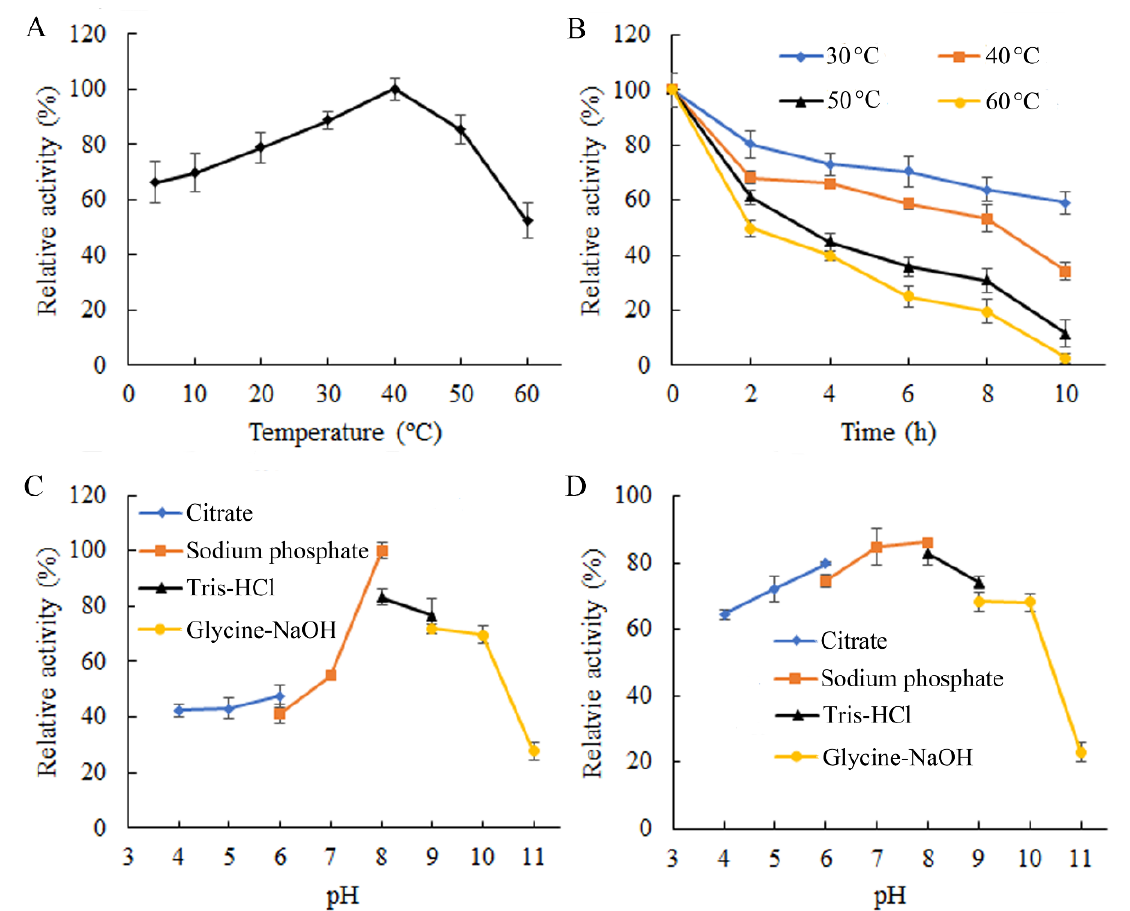
Figure 3. Enzymatic properties of ChSase B6. ( A ) Enzymatic activity of ChSase B6 at different temperatures. Activity at 40 °C was taken as 100%; ( B ) thermostability of ChSase B6. The enzyme activity without heat treatment was taken as 100%; ( C ) enzymatic activity of ChSase B6 under different pH conditions. Activity at pH 8.0 was taken as 100%; ( D ) pH stability of ChSase B6. The enzyme activity without pH treatment was taken as 100%. Each value represents the mean of three replicates ±SD. Table 2. The enzymatic properties of some chondroitinases of bacterial origin.